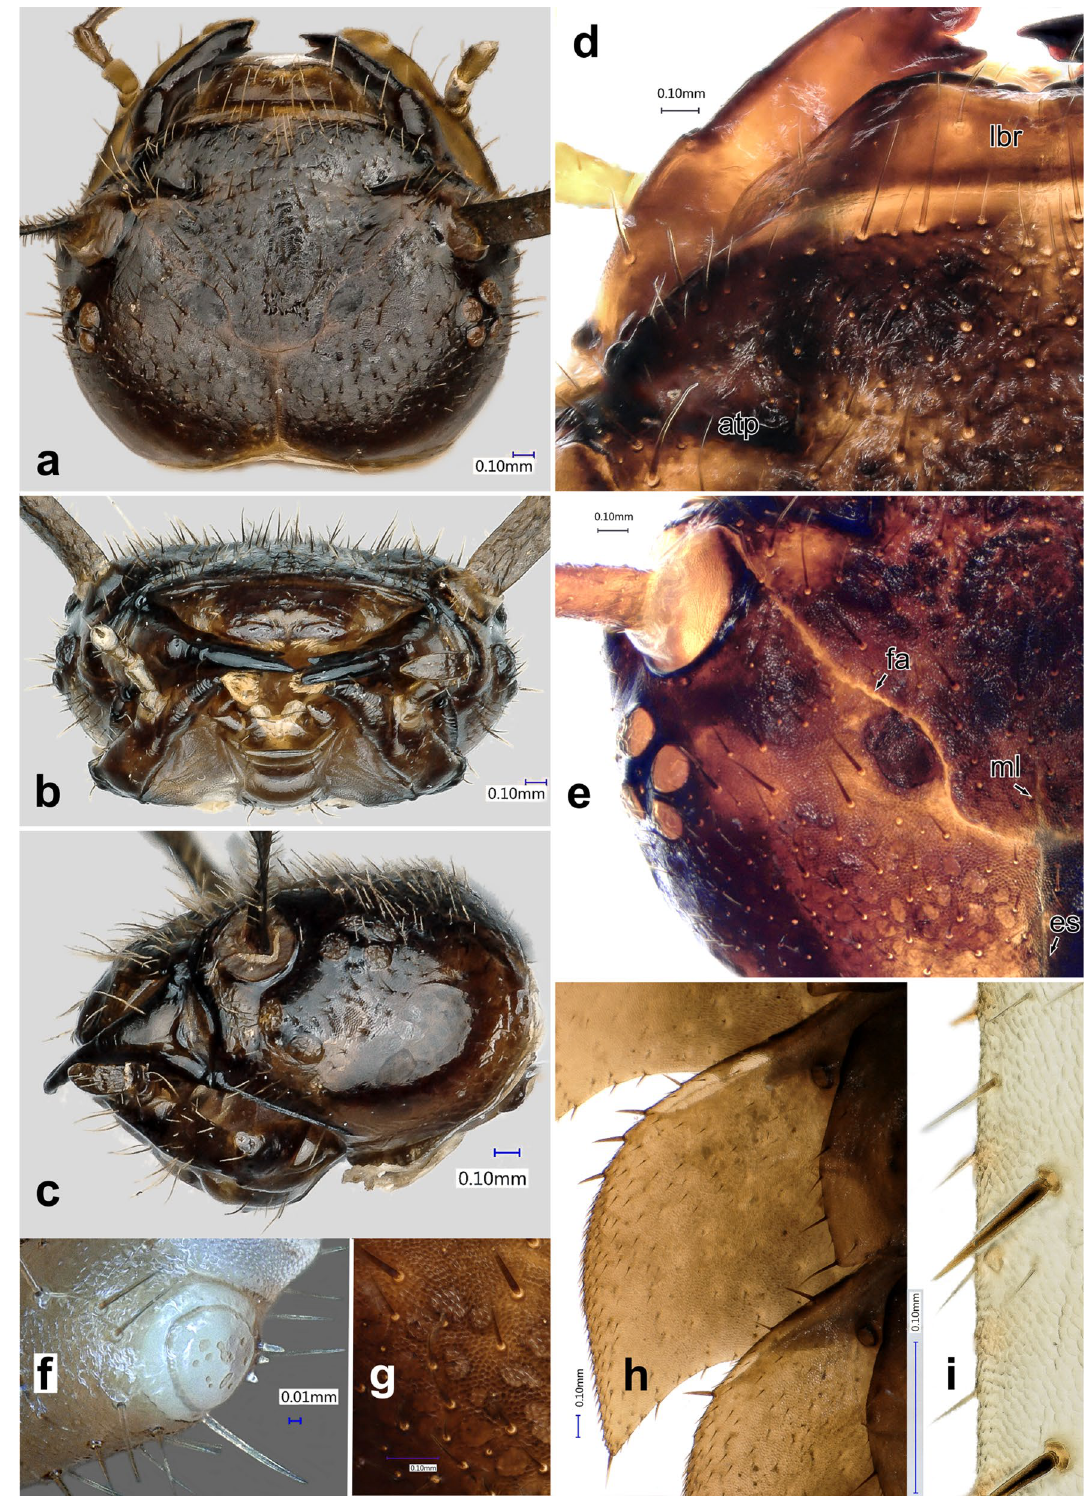
Figure 6. Heterotemna tenuicornis (Brullé, 1836), details of external morphology of larva, third instar: ( a ) head, dorsal view; ( b ) head, anterior view; ( c ) head, left lateral view; ( d ) detail of labrum and frons, dorsal view; ( e ) detail of epicranial plate with epicranial stem and frontal arms; ( f ) sensorium on antennomere II, dorso-lateral view; ( g ) epicranium, detail of surface, dorsal view; ( h ) abdominal paratergite, ventral view; ( i ) setation on tibiotarsus, lateral view. Abbreviations: atp anterior tentorial pits, es epicranial stem, fa frontal arms, lbr labrum, ml median